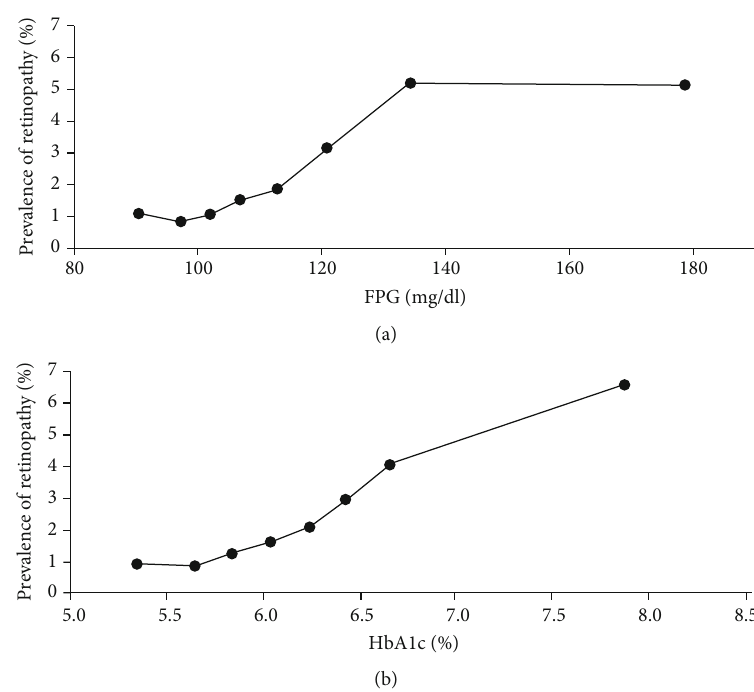
Figure 1: (a) Prevalence of retinopathy according to the levels of FPG. The x -axis shows the average of each group. (b) Prevalence of retinopathy according to the levels of HbA1c. The x -axis shows the average of each group.